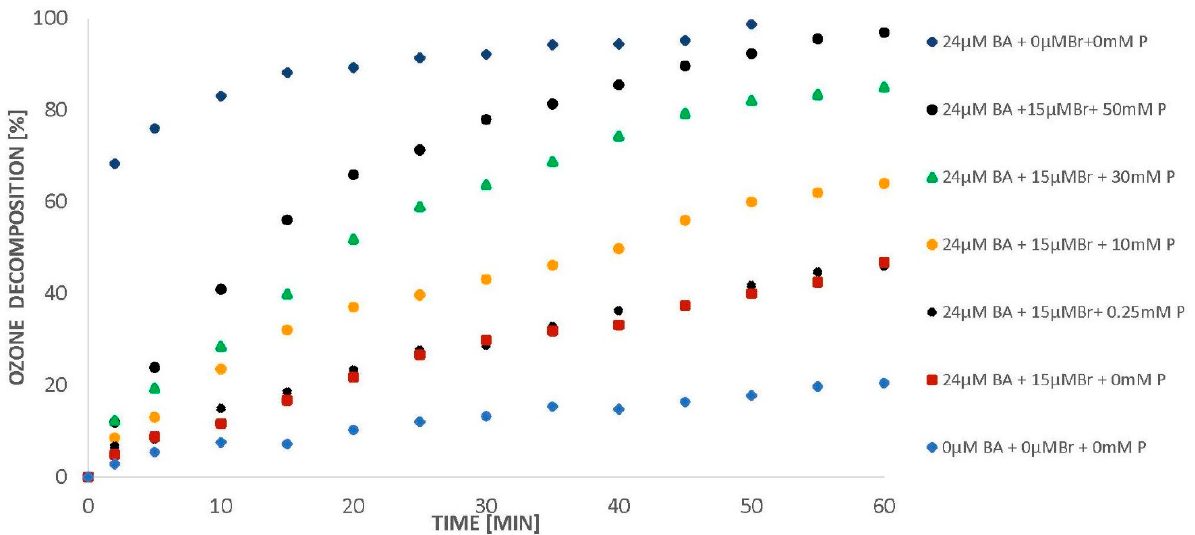
Molecules 2021 , 26 , x FOR PEER REVIEW 7 of 15 Figure 5. Ozone decomposition in the presence of BA (24 µM), bromides (15 µM), and phosphates ( p = 0–50 mM), pH = Figure 5. Ozone decomposition in the presence of BA (24 µ M), bromides (15 µ M), and phosphates ( p = 0–50 mM), pH = 2.5. 2.5.